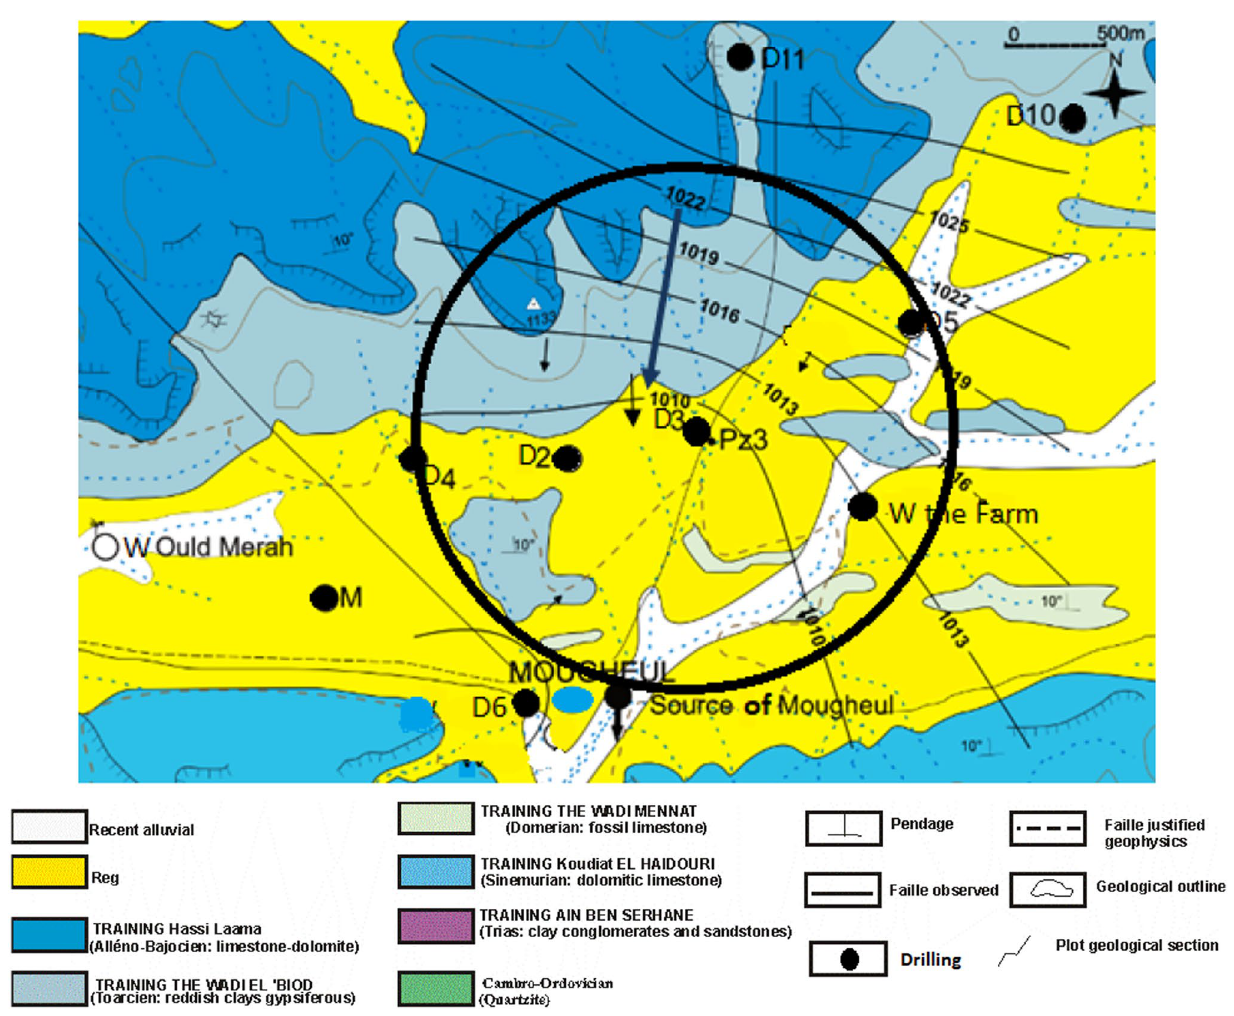
Fig. 9 Area of influence of D3 drilling (Mebarki